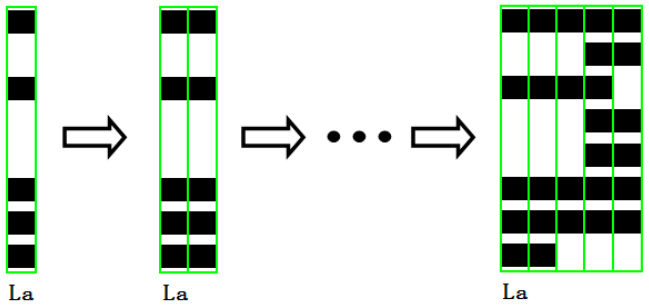
9 of 25 Figure 8. Example of a dense piece and sparse piece: ( a ) dense piece; ( b ) sparse piece. The black area represents characters, and the white area represents blank spaces. In general, the dense pieces are located in area 3 of a document, while the sparse pieces are located in areas 1 and 2. The sparse pieces associated with